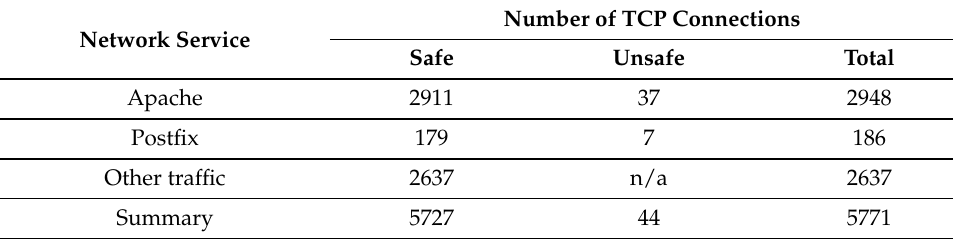
Table 1. Network traffic statistics from